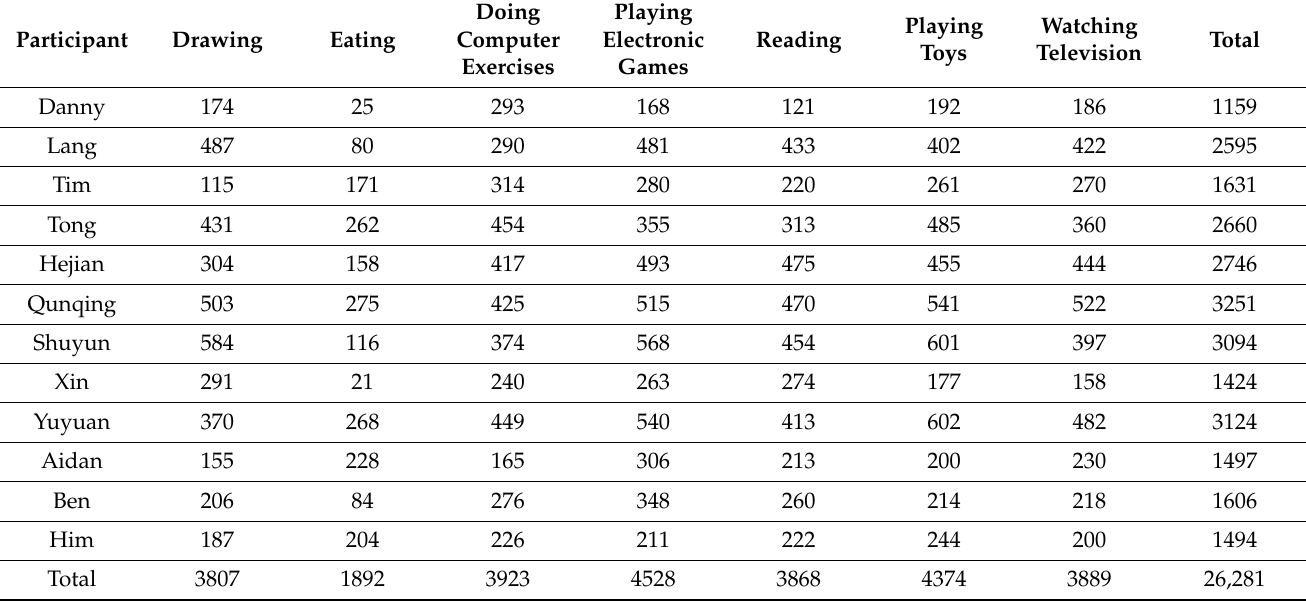
Table 2. The total numbers of the retained samples when different participants are conducting different activities under the immersion